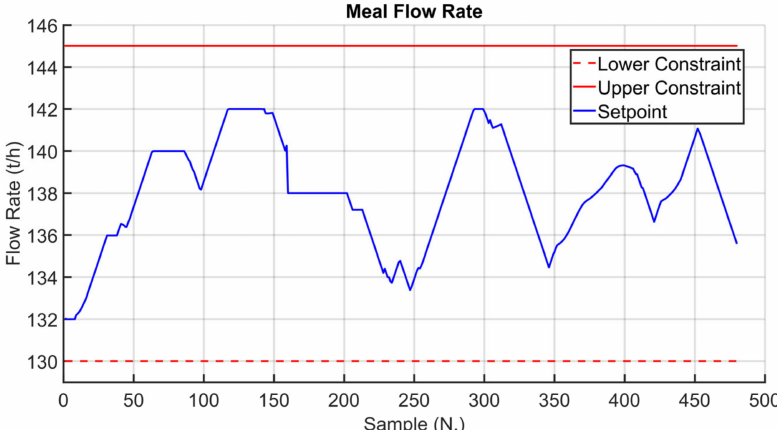
Figure 17. Rotary kiln APC system: virtual environment simulations results (meal flow rate MV).